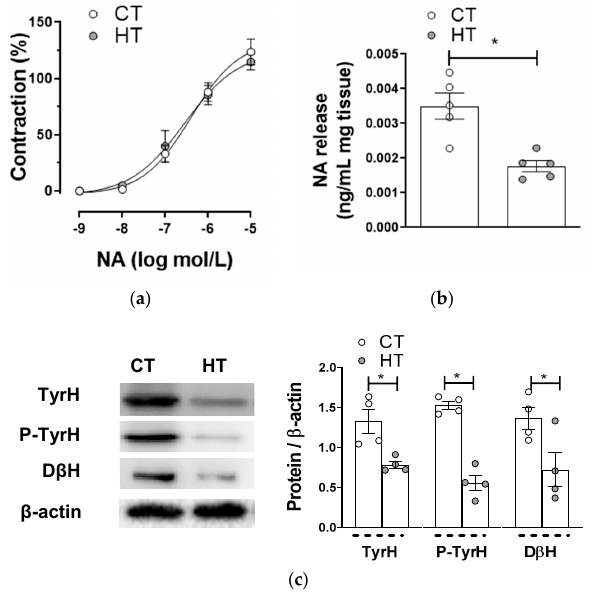
Figure 3. ( a ) Vasoconstrictor response to exogenous noradrenaline (NA) in mesenteric arteries from control (CT) and hyperthyroidic (HT) rats. Results (mean ± S.E.M.) are expressed as a percentage of the previous tone elicited by KCl. n = 4-6 segments from different animals in each experimental group. ( b ) EFS-induced NA release in mesenteric segments from CT and HT. Results (mean ± S.E.M.) are expressed as ng NA/mL mg tissue. n = 5 animals per group. * p < 0.05 CT vs. HT (Student’s t-test). ( c ) Effect of hyperthyroidism on tyrosine hydroxylase (TH) expression and activation (P-TyrH), and in dopamine β hydroxylase (D β H) expression. The blots are representative of four separate segments from each group. Right panel shows a relation between each protein expression and β -actin. Results (mean ± S.E.M.) are expressed as a ratio of the signal obtained for each protein and the signal obtained for β -actin. * p < 0.05 CT vs. HT (Student’s t -test). Sympathetic neurotransmission involves simultaneous NA and ATP release, both acting on VSMC. Preincubation with 0.1 mmol/L suramin, a non-specific P2 purinergic receptor antagonist, decreased EFS-induced contraction only in CT segments. Moreover, preincubation with phentolamine plus suramin abolished this EFS-induced contraction in CT segments from both groups (Figure 4a,b). To sum up, the abolishment of purinergic co-transmission observed in HT might also participate in the diminished sympathetic function in superior mesenteric arteries from these animals.